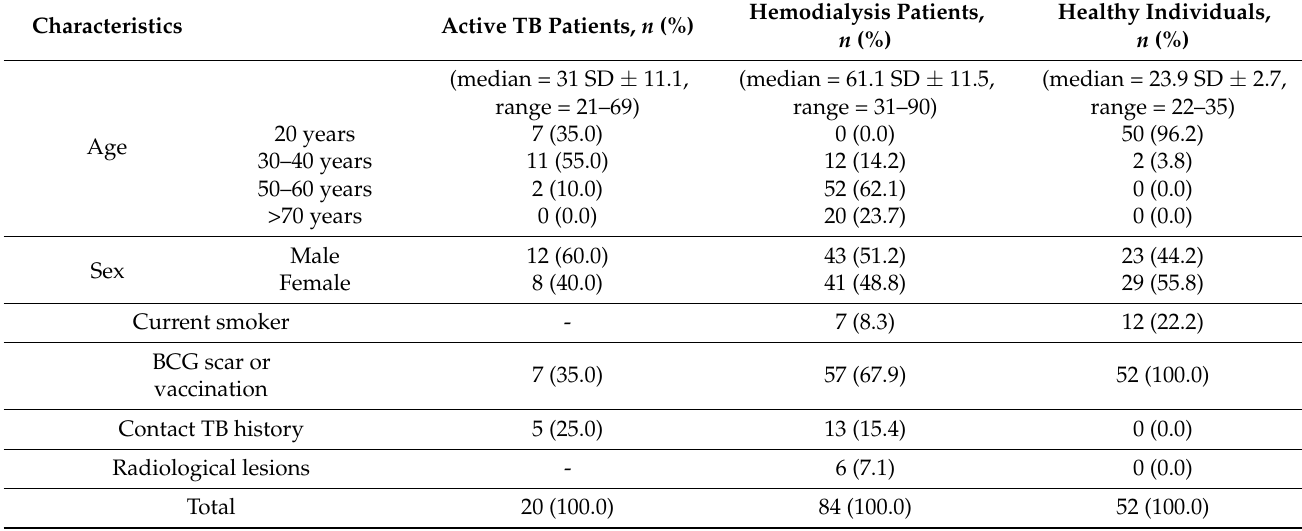
Table 1. Characteristics of study